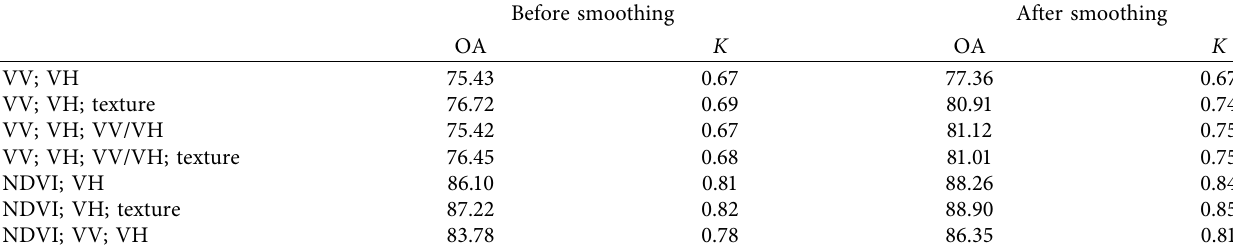
Table 6: Improved overall precision and Kappa indices by applying smoothing. Before smoothing After smoothing